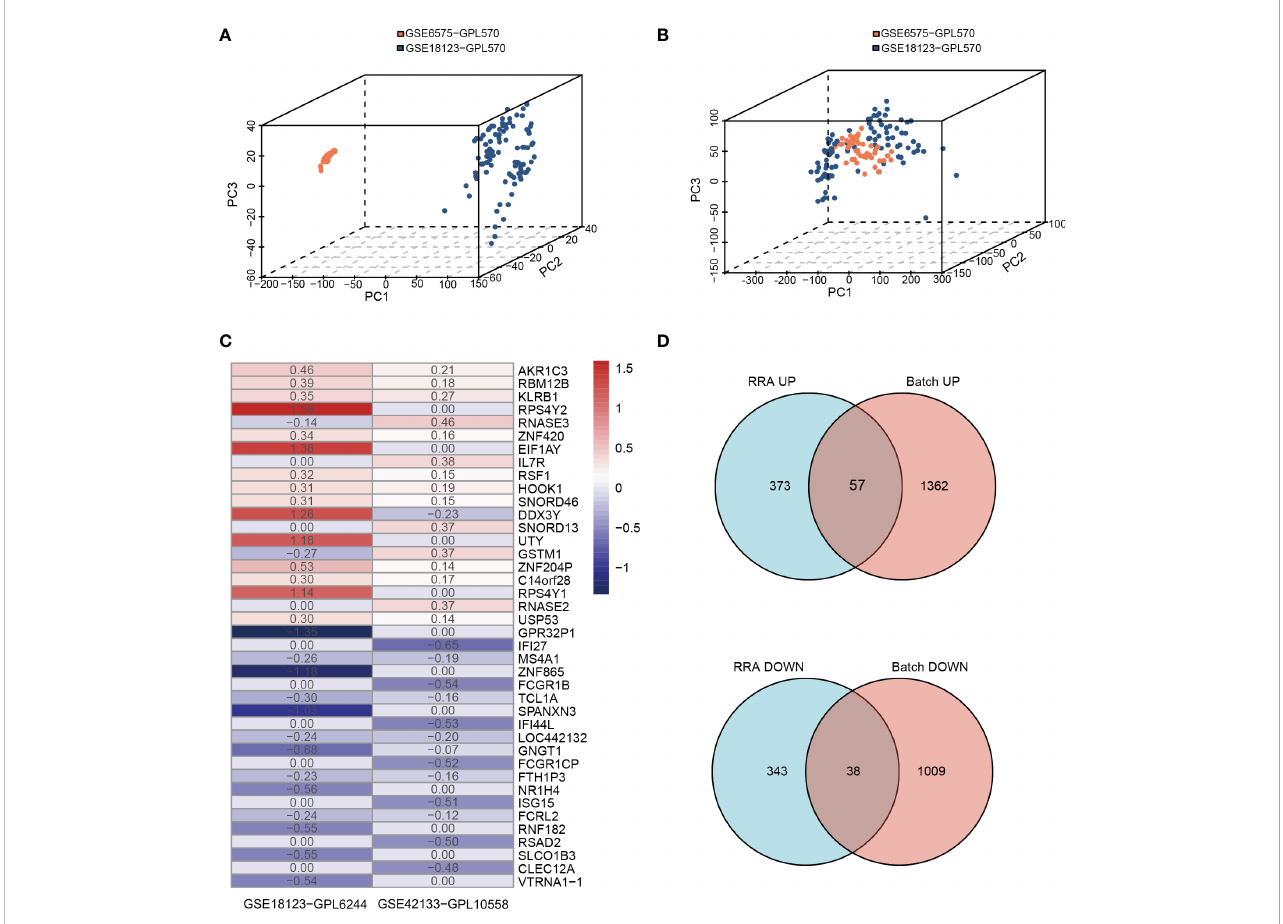
FIGURE 2 Identifying the DEGs from two methods in children ’ s databases. (A, B) Principle component analysis of the batch correction of GSE6575 and GSE18123: (A) before batch correction and (B) after batch correction. (C) The top 20 upregulated and 20 downregulated DEGs of the different platforms from two datasets determined by “ RRA ” . (D) Venn diagram showing the consistently changing DEGs screened by “ RRA ” and “ Batch ”